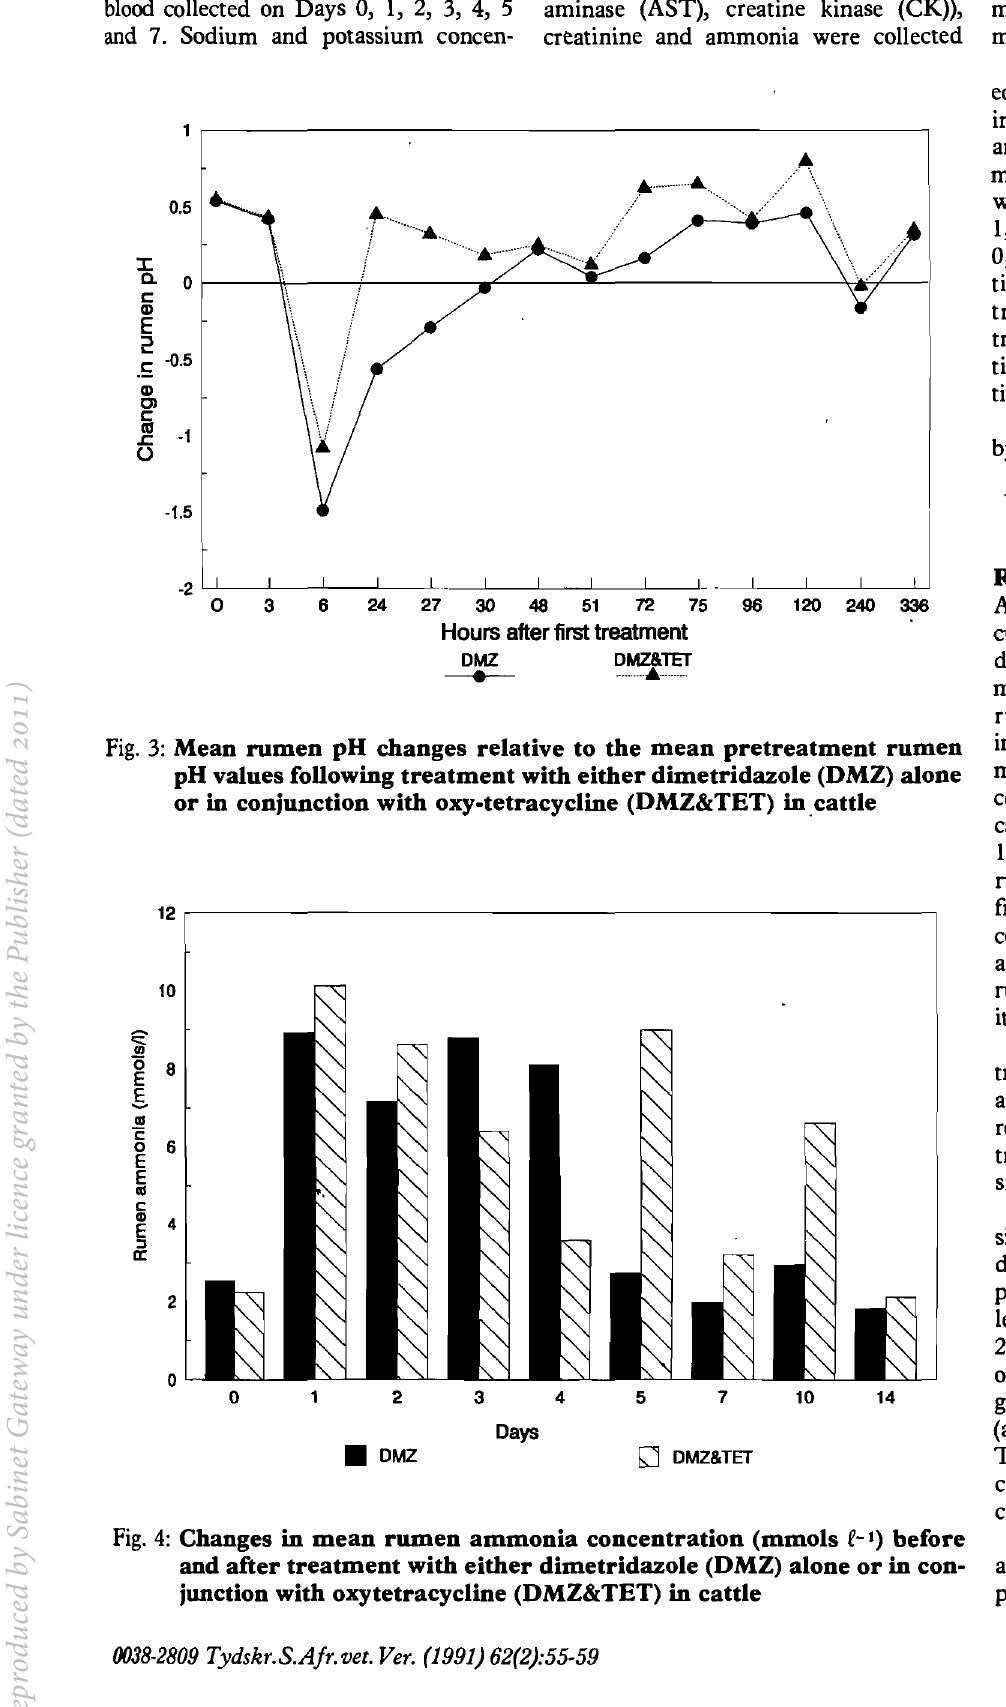
Fig. 4: Changes in mean rumen ammonia concentration (mmols e- t) before and after treatment with either dimetridazole (DMZ) alone or in con junction with oxytetracycline (DMZ&TET) in cattle 0038-2809 Tydskr.S.Afr.vet. Ver. (1991)